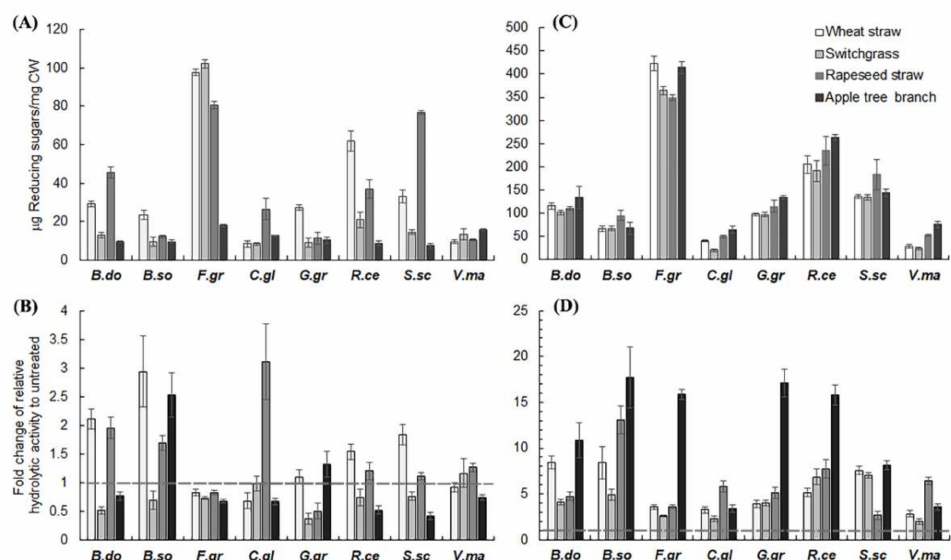
Figure 3. Enzymatic hydrolysis of cell wall substrates of wheat straw, switchgrass straw, rapeseed straw, and apple tree branch pretreated by hemicellulases ( A ) or PAA ( C ). ( B , D ) Fold-changes of hydrolytic activities of pathogenic fungi on hemicellulase- and PAA-pretreated substrates vs. untreated substrates,